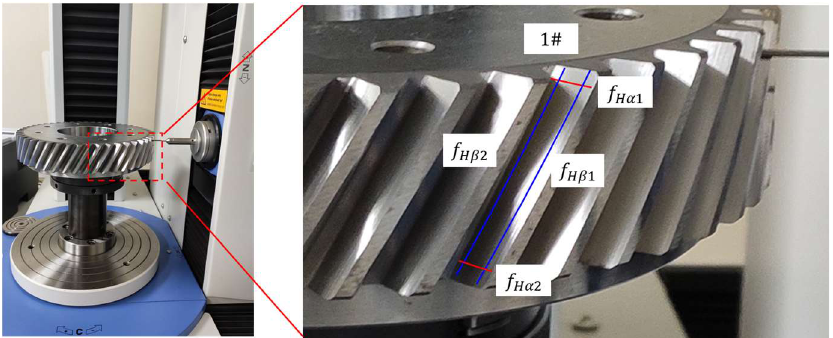
Figure 5. Using P26 to measure the test gear.